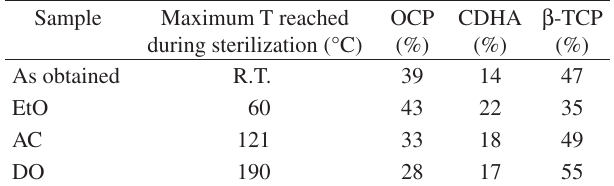
Table 1. Semi-quantitative phase composition of the studied material before and after the treatment by the different sterilization methods, as estimated from thermo gravimetric analysis data.